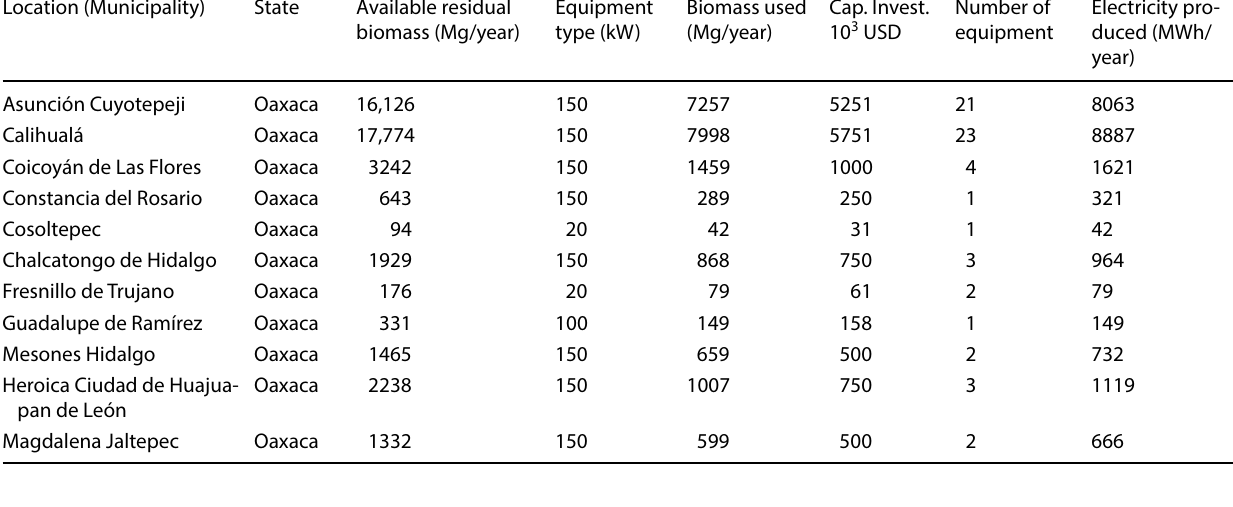
Table 5 Extract of Small-scale sites in Oaxaca state for electricity generation using Gasifiers Location (Municipality)